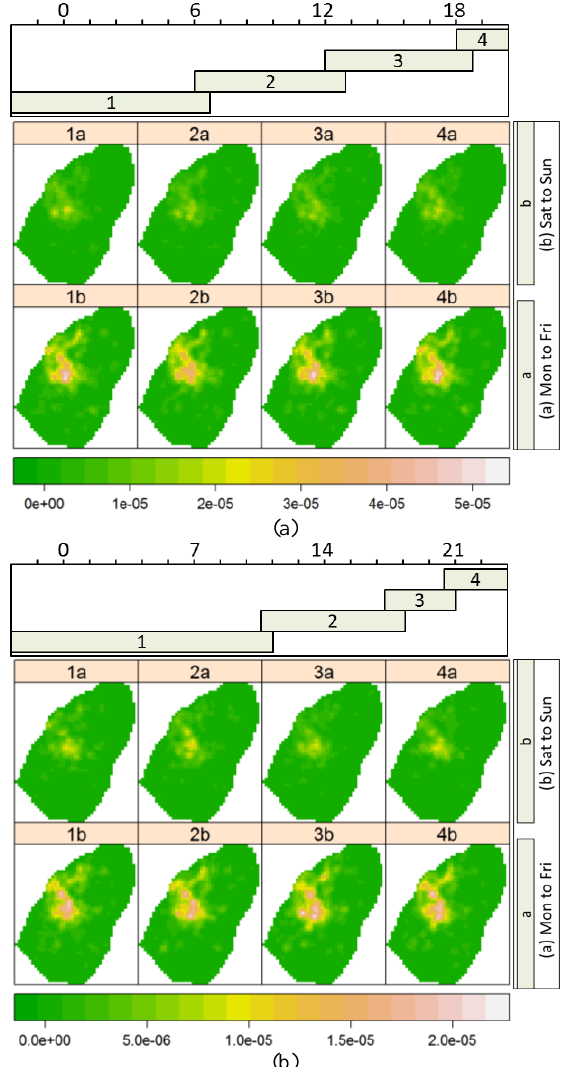
Figure 10. Bivariate comaps by week and hour: (a) DW; (b) FL The interaction of space and time is examined by